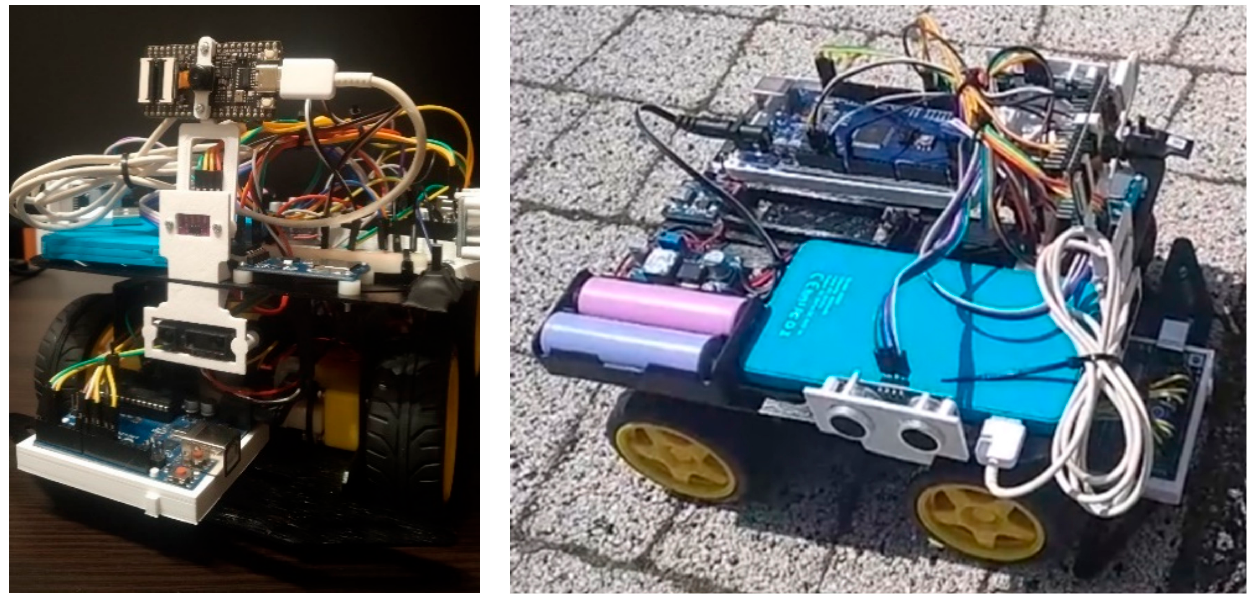
Figure 16. The real structure of platform.